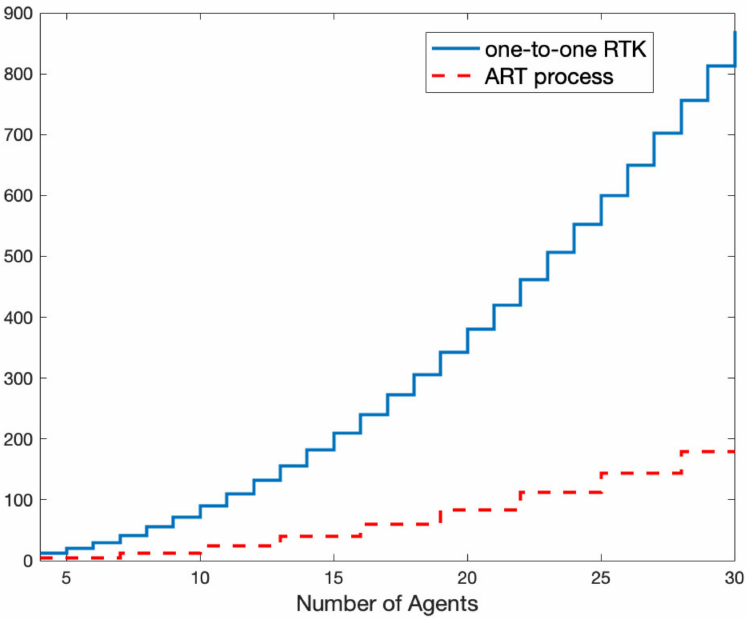
Figure 12. Comparison of the number of computations between one-to-one RTK and ART process with respect to the number of